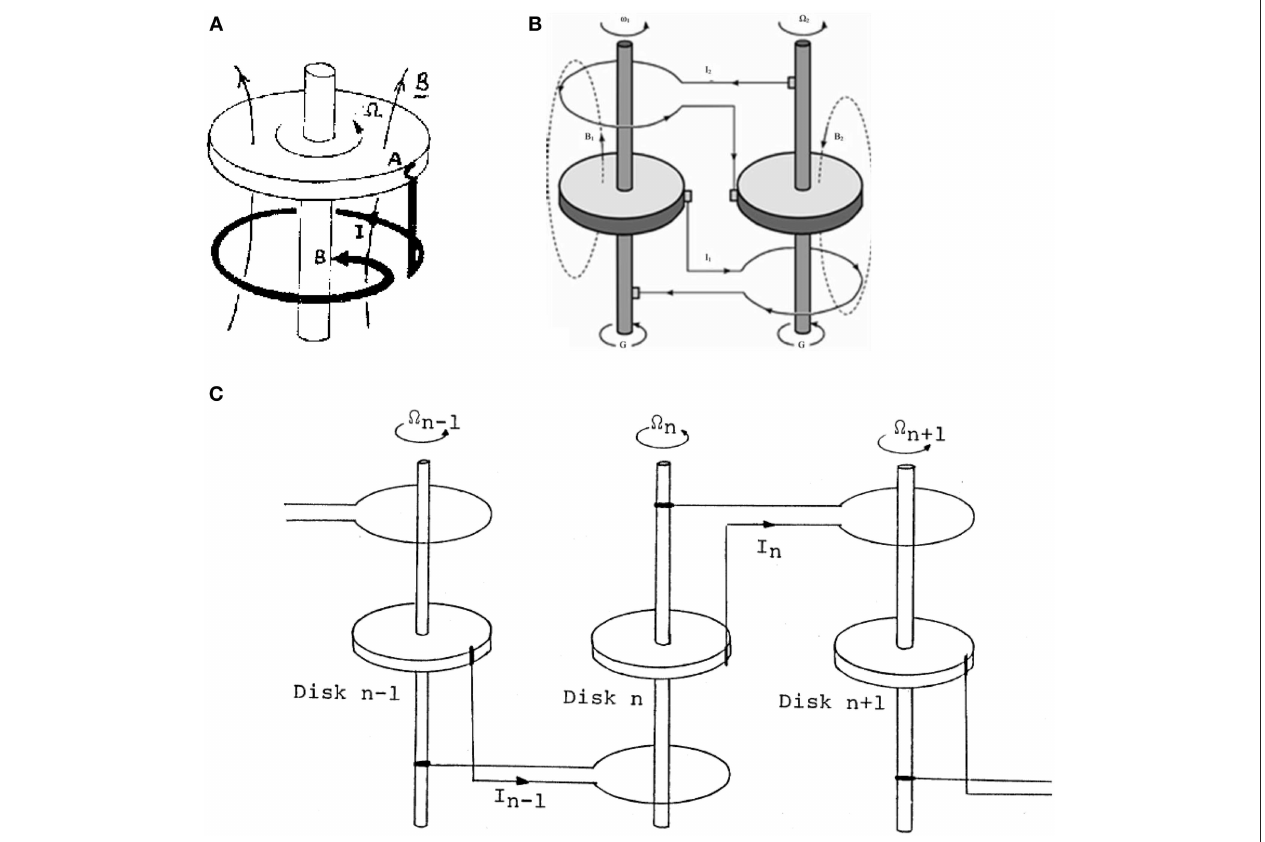
FIGURE 2 | (A) Homopolar disk dynamo (adapted from Leprovost et al., 2005); (B) a sketch of the Rikitake disk dynamo (adapted from Yajima and Nagahama, 2009); (C) a sketch of the IL model consisting of N disks arranged in a circle. The main disk is not shown here (adapted from Shimizu and Honkura, 1985).